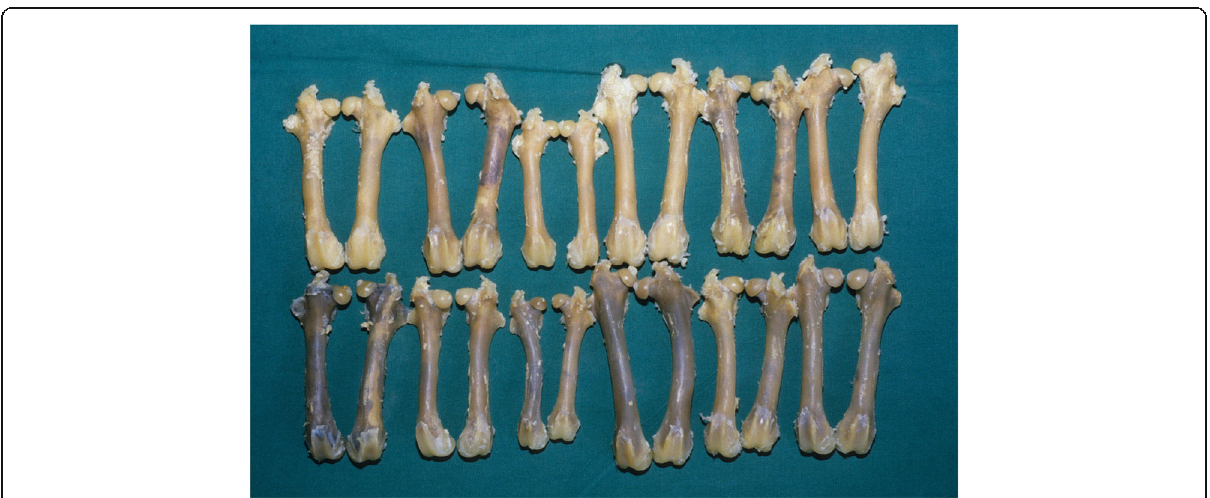
Fig. 4 Top row steroid treated bones are whiter due to more barium retention. Bottom row controls are darker and contain less barium than the